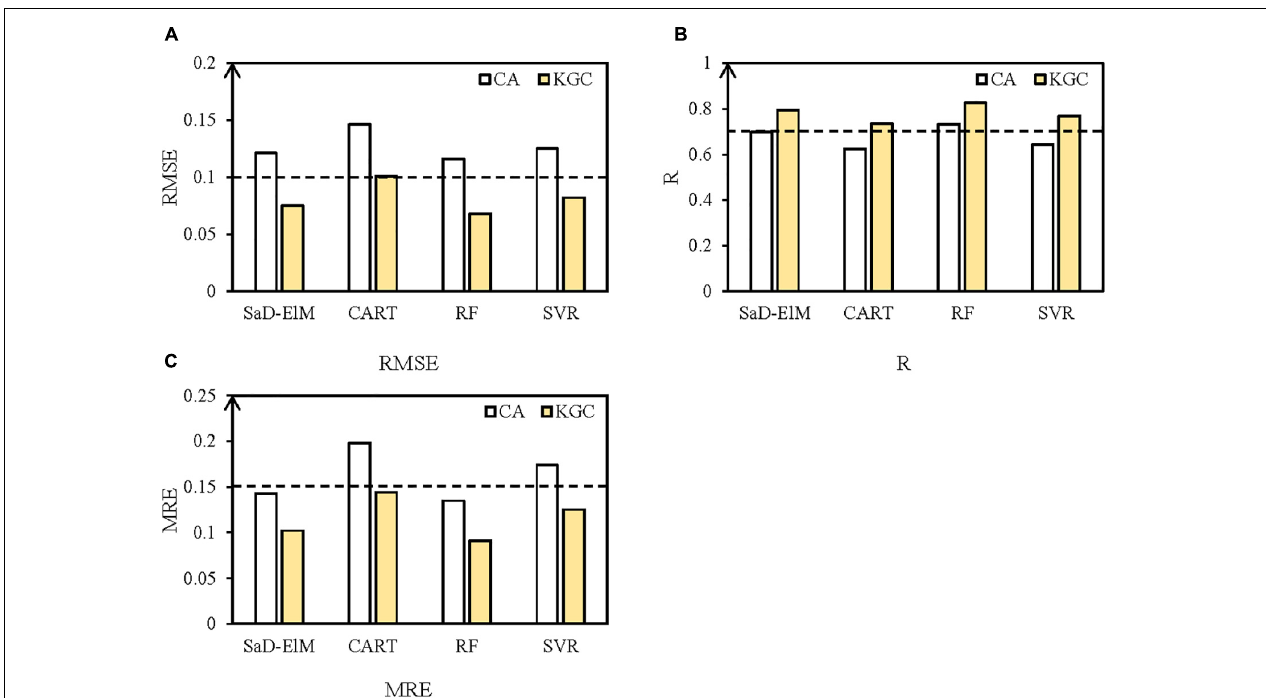
FIGURE 5 | (A) R, (B) RMSE, and (C) MRE of mean predicted SIC with different prediction models. White represents the prediction based on correlation analysis; yellow represents the prediction based on causal analysis.